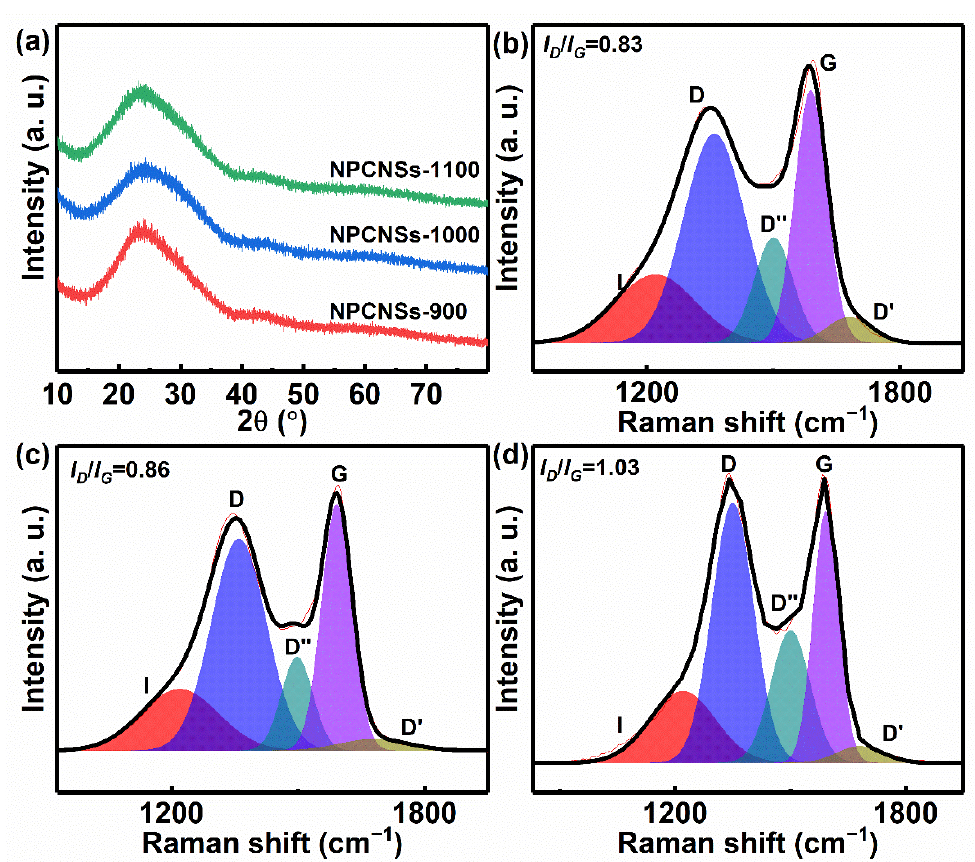
Figure 3. ( a ) XRD patterns of NPCNSs- y ( y = 900, 1000, and 1100), Raman spectra of ( b ) NPCNSs-900, ( c ) NPCNSs-1000, and ( d ) NPCNSs-1100.